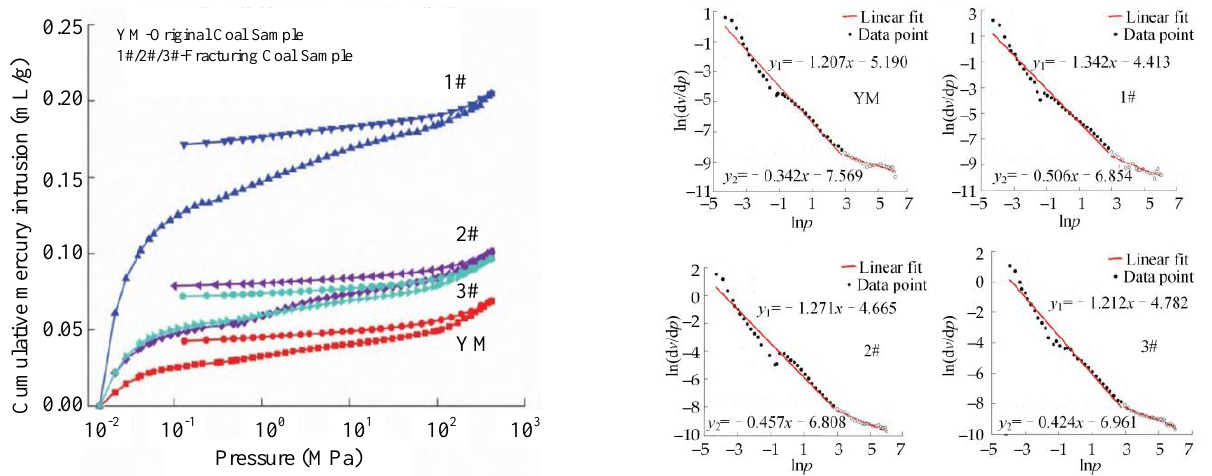
Figure 21. Mercury injection test curve and fractal characteristics [48].